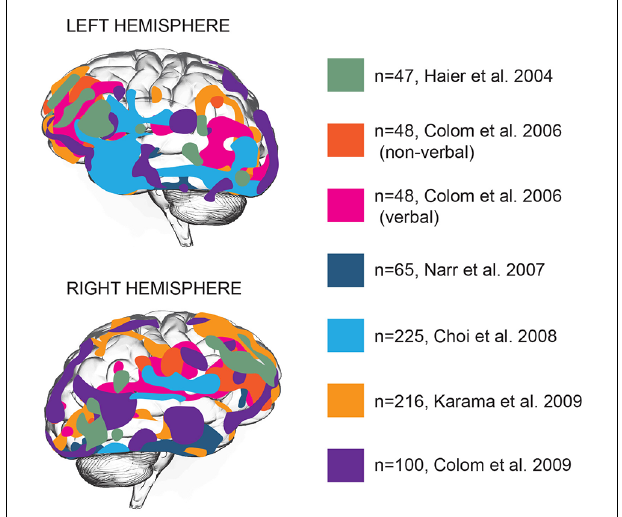
FIGURE 1 | Gray matter thickness of multiple cortical areas correlates with general intelligence. Brain areas with significant association between cortical thickness and general intelligence in different studies are represented by different colors. N numbers represent sample sizes. In all cases the areas correlating with general intelligence are shown, with the exception of the Colom’s (2006) study, where verbal and non-verbal intelligence were reported separately (Haier et al., 2004; Colom et al., 2006, 2009; Narr et al., 2007; Choi et al., 2008; Karama et al.,